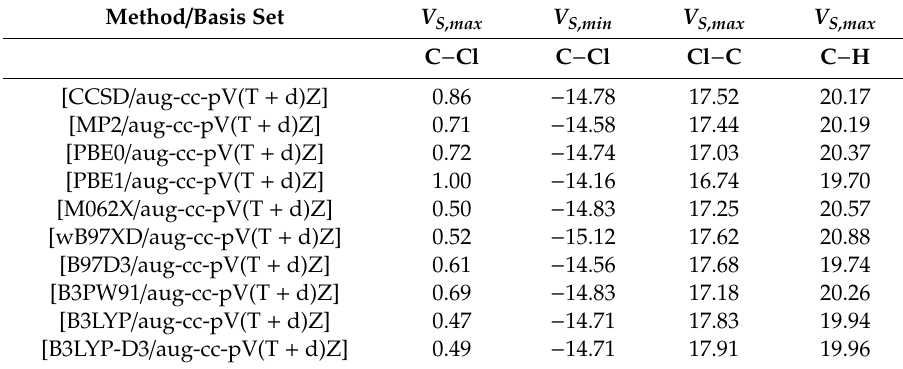
Table 1. The 0.001 a.u. isodensity envelope mapped electrostatic potential on the outer surface of various bonded atoms in CH 3 Cl, computed using various computational approaches in conjunction with the aug-cc-pV(T + d)Z basis